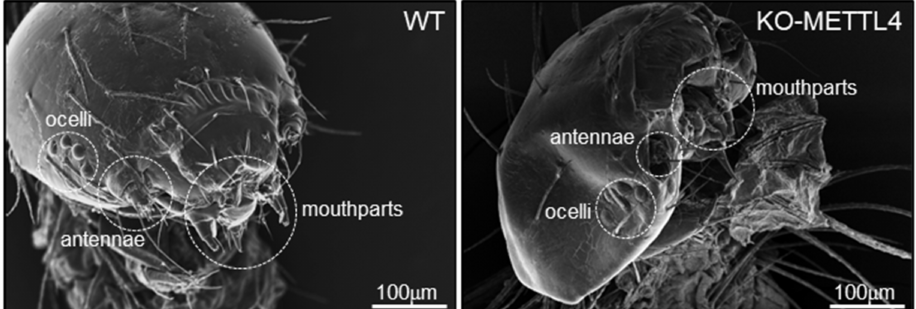
Figure 8. Morphological observation of the silkworm head in the WT and KO-METTL4 mutant. Representative images of the silkworm head of the WT and KO-METTL4 mutant as examined by SEM microscope. The structures of mouthparts, antennae, and ocelli were labeled by broken circles. Scale bar is 100 µ